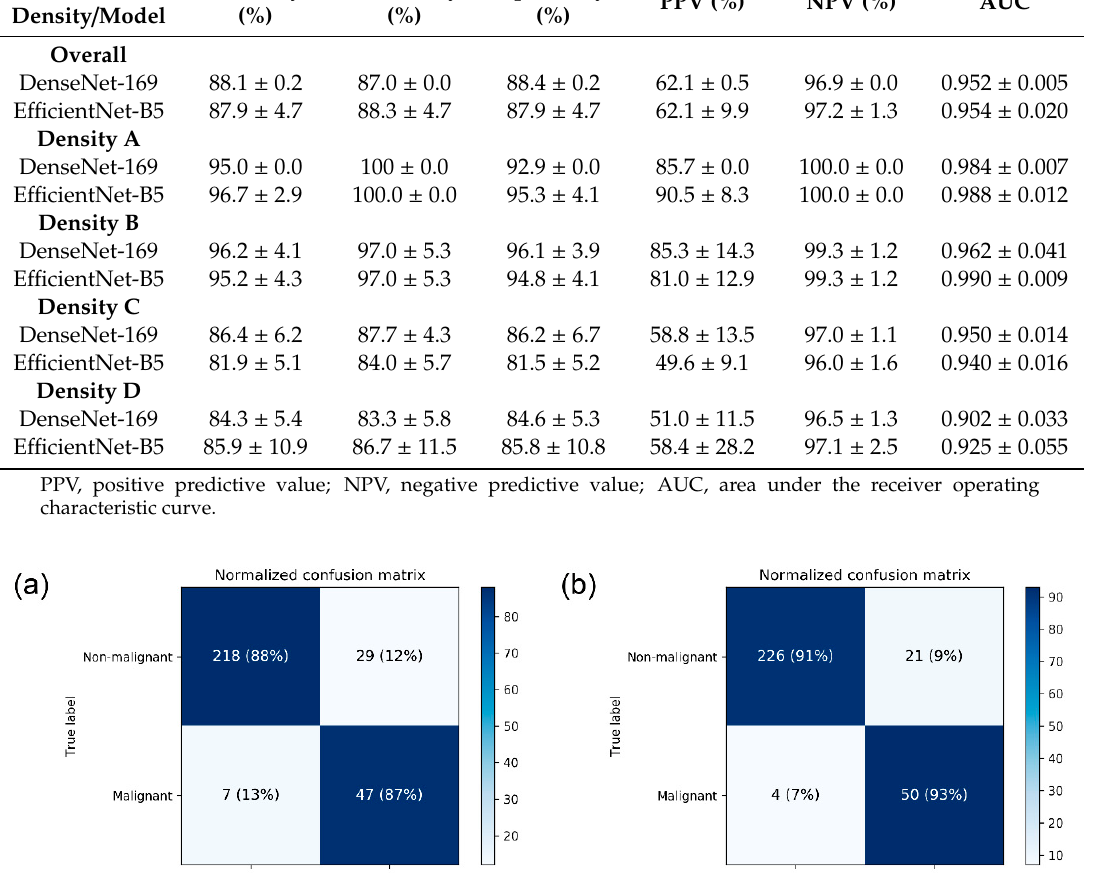
Figure 3. Receiver operating characteristic curves for detecting breast cancer on digital mammograms by the best performing ( a ) DenseNet-169 and ( b ) EfficientNet-B5. 3.4. Grad-CAM Examples of Grad-CAM images are presented in Figure 4. The CNN models detected malignant lesions efficiently. In the merged mammograms, the malignant lesions were mostly detected appropriately in both craniocaudal and mediolateral oblique view images. The CNN models focused on the interface between breast cancer and surrounding parenchyma. The radiopaque area contributed to cancer prediction more than the radiolucent area. Of note, the CNN models tended to identify the abnormalities in the form of mass or calcification rather than architectural distortion or asymmetry. However, radiopaque structures with normal structures were disregarded because they